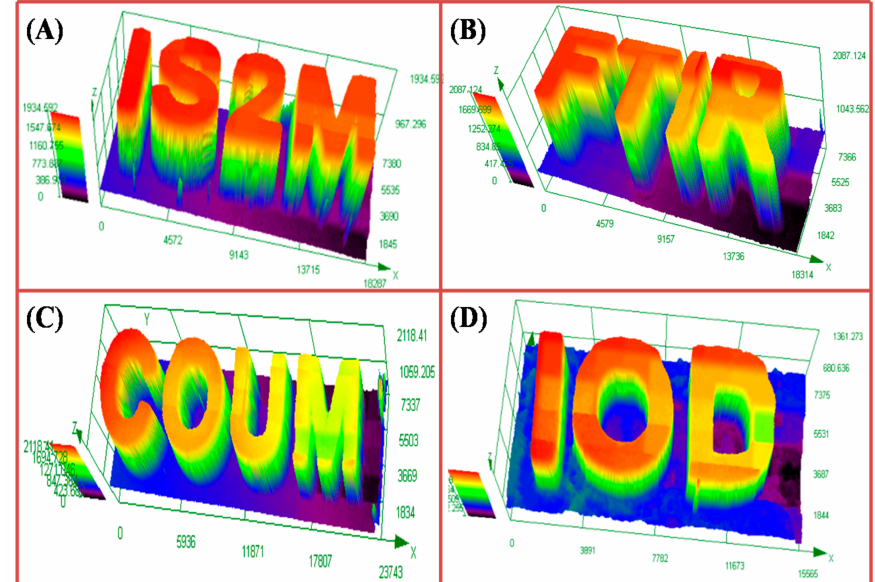
Figure 2. Characterization of the 3D patterns by numerical optical microscopy; ( A ) Coum2 / Iod / 4-N,N TMA (0.024% / 0.4% / 0.16% w / w / w ) in TA; ( B ) Coum1 / Iod / 4- N ,N TMA (0.02% / 0.4% / 0.16% w / w / w ) in TA;